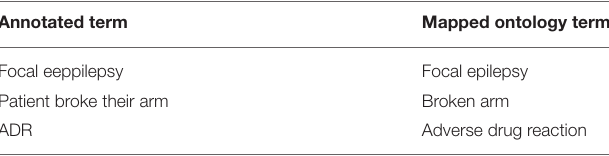
TABLE 1 | Mappings of terms, as found in a clinical letter, to standardised versions of the terms in an external ontology. Annotated term